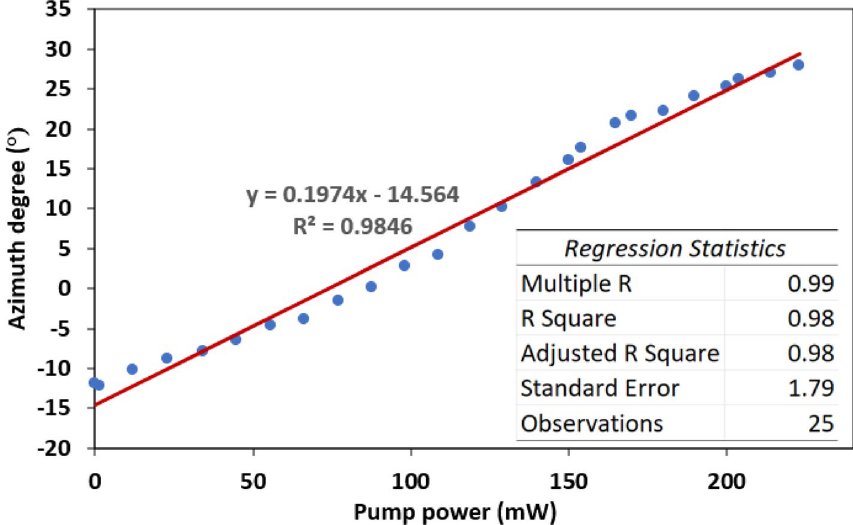
Figure 7. Rotation of light azimuth versus pump power.